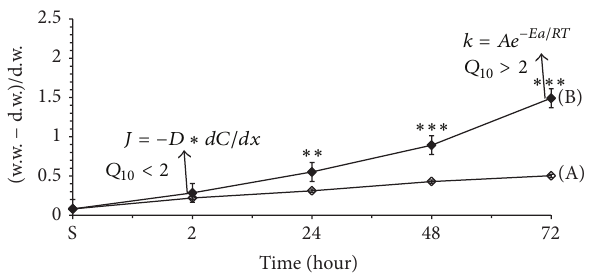
Figure 3: Time-dependent changes in seed hydration during 72 hours of incubation in nontreated (“ 𝐶 ” = Sham) DW in cold (4 ∘ C; (A) clear symbol) and warm (20 ∘ C; (B) dark symbol) conditions. S = initial reading at 5 minutes after the start of the incubation.